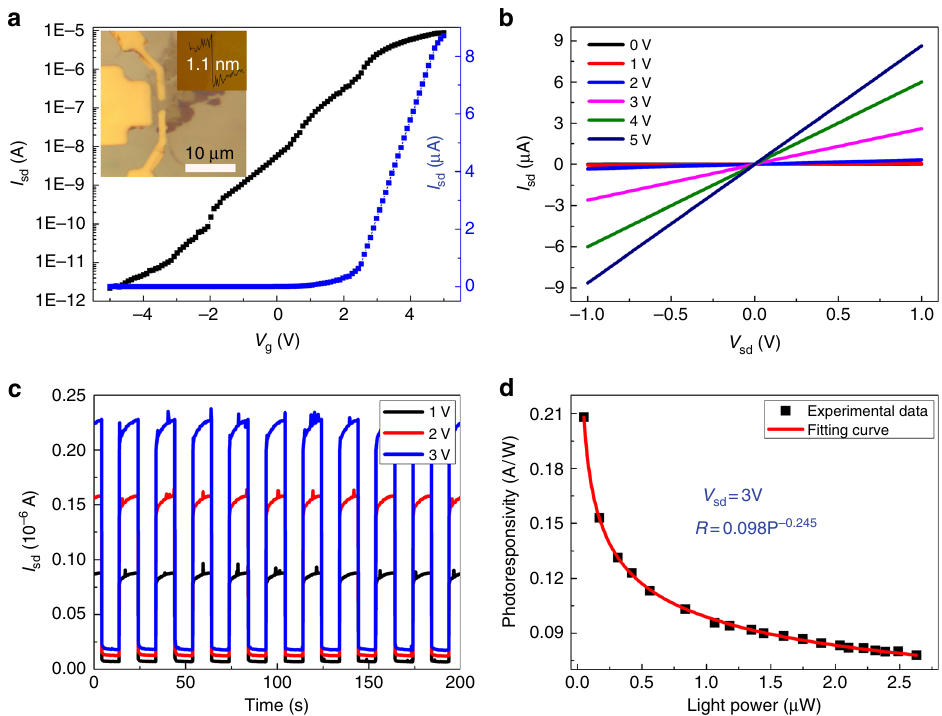
Fig. 2 Electrical characteristics and photoresponse of the Fe 0.021 Sn 0.979 S 2 monolayer. a Transfer and b output characteristics of Fe 0.021 Sn 0.979 S 2 . The inset shows an optical image of one typical device and the AFM image of the corresponding sample used for fabricating the device. c Time-dependent I sd of the transistor based on Fe 0.021 Sn 0.979 S 2 during the light (638 nm, 2.63 μ W) switching on/off under a positive source – drain voltage, V sd , from 1 to 3 V. d Photoresponsivity ( R ) as a function of light power ( P ) with a V sd of 3 the nanosheet contains S, Sn, and Fe elements. Using a high- (Fig. 1g), and each Fe atom is surrounded by six S atoms to form an octahedral coordination. The oxidation state of the Fe the Sn ( Z = 50), Fe ( Z = 26), and S ( Z = 16) atoms were directly atom should be +4, leading to a high binding energy for Fe 2 p 3/2 in Fe 0.021 Sn 0.979 S 2 . Furthermore, quantitative analysis of the XPS spectra reveals that the content of Fe is ∼ 2.1% in Fe 0.021 Sn 0.979 S 2 . Electronic and optoelectronic properties of Fe-doped SnS 2 . To